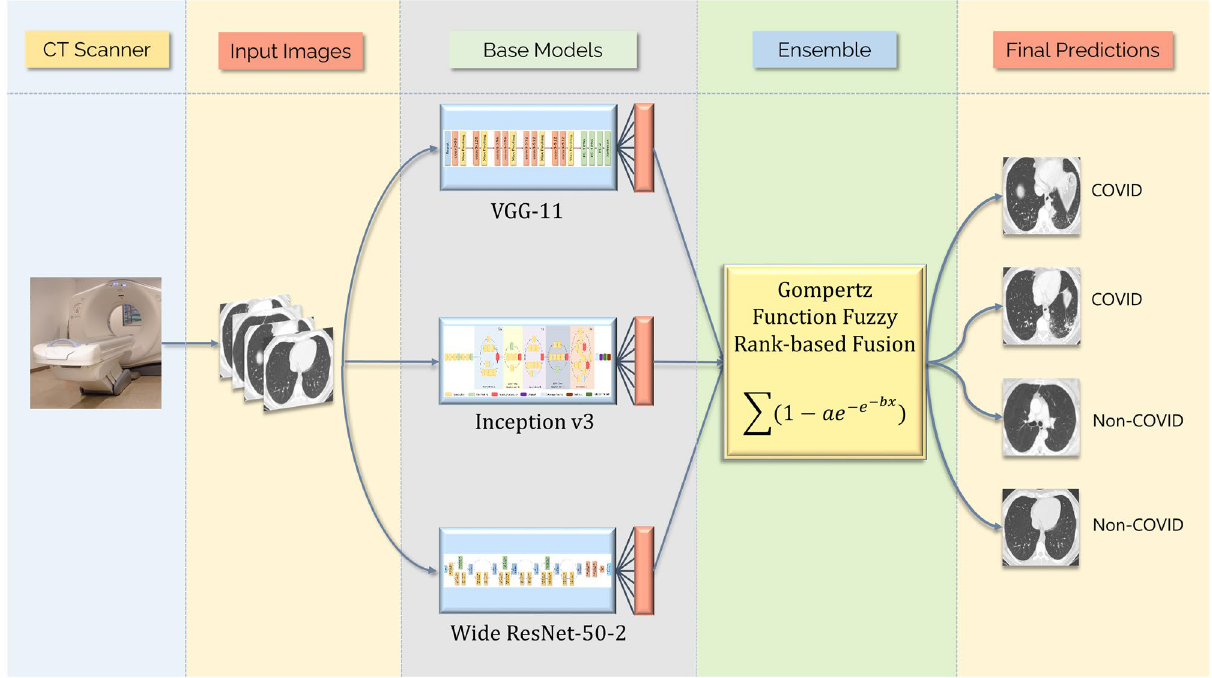
Figure 2. Overall workflow of the proposed framework. The CT Scanner image (open access) is obtained from the Progressive Diagnostic Imaging website 34 and the chest CT scan images are from the SARS-COV-2 dataset 15 used in this research.